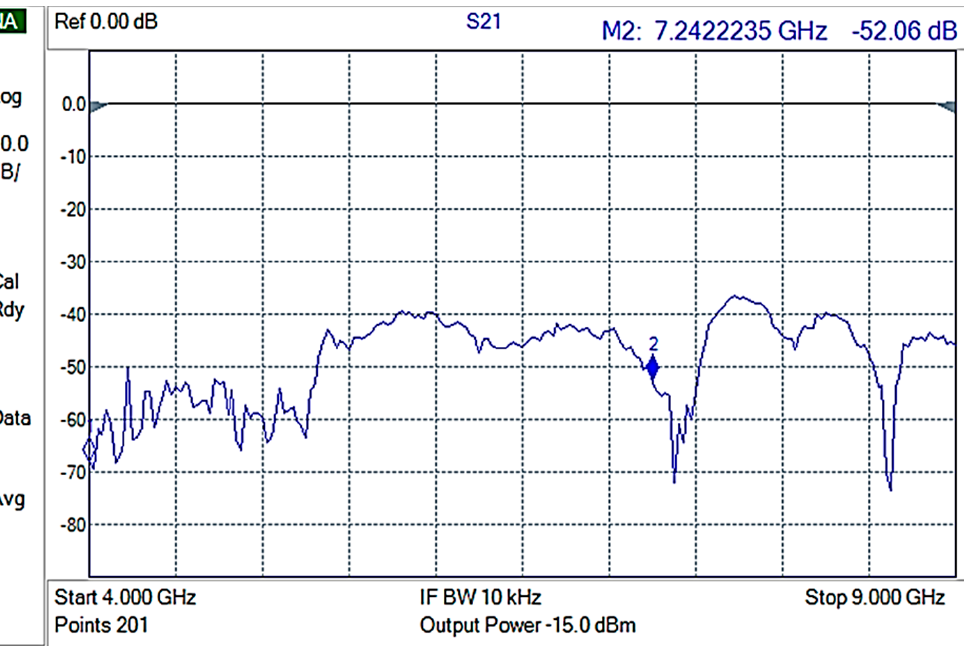
Figure 9. S21 for GNPS-PP composite materials. The best EMI shielding properties were obtained for 10% CNTs-PP composite materials, as presented in Figure 10.